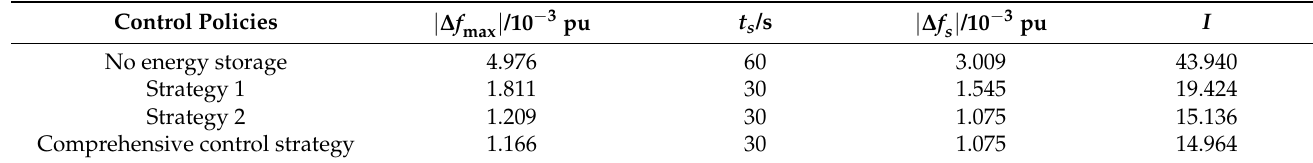
Table 3. Evaluation indexes of FM under step load disturbance.